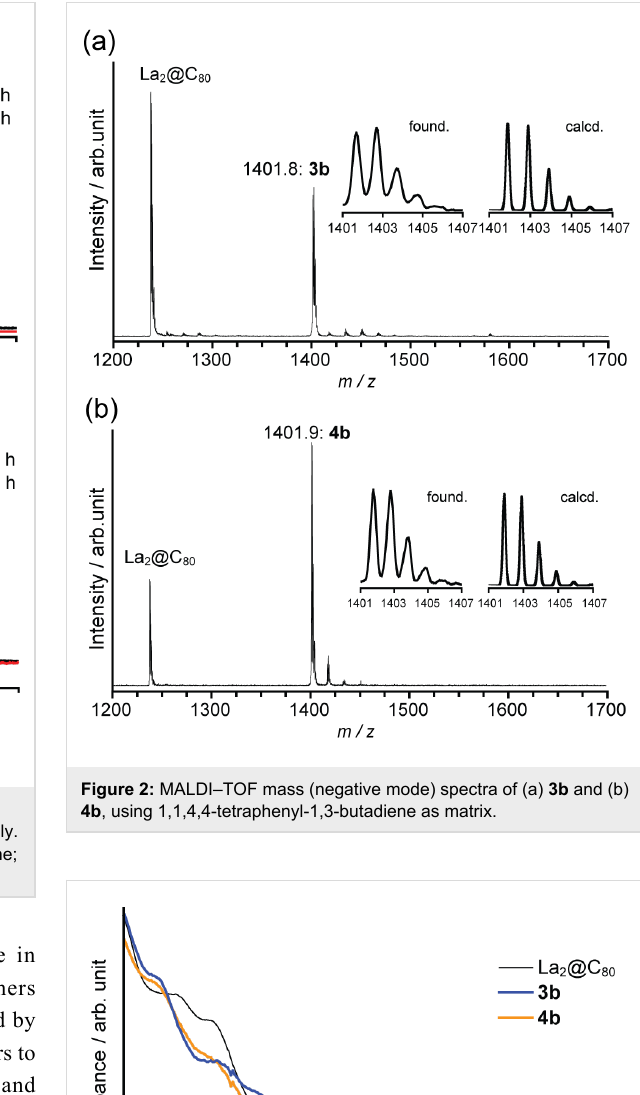
Figure 3: UV–vis/near-IR absorption spectra of 3b and 4b recorded by the diode array detector of the HPLC apparatus.